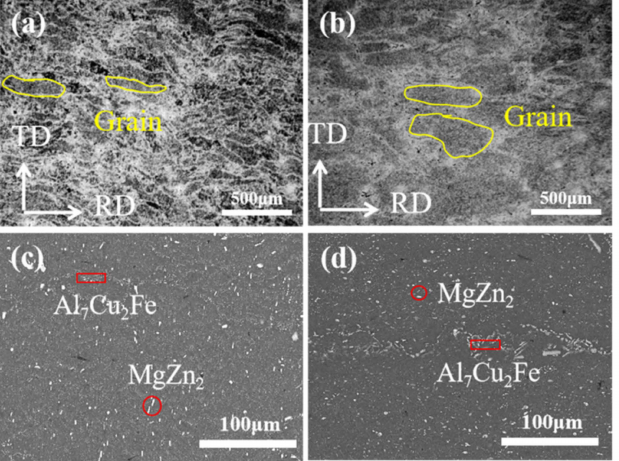
Figure 1. Grain structure and SEM results of hot rolled plates: ( a , c ) 25 mm; ( b , d ) 65 mm.